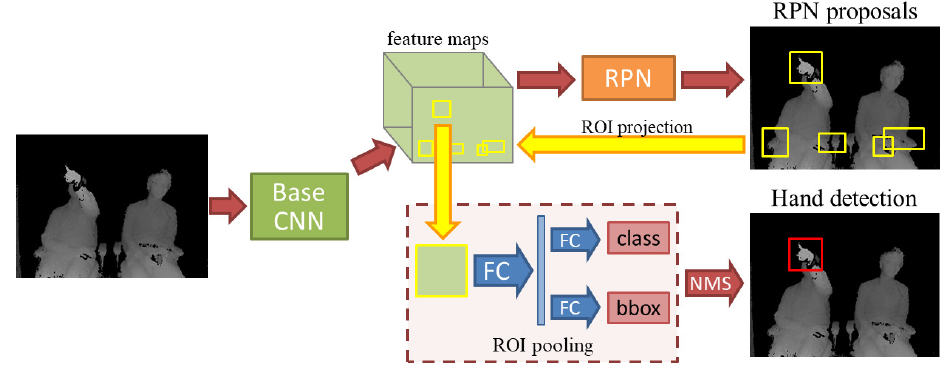
Figure 3. Hand detection process based on faster RCNN [30]. The raw frame is processed by the base CNN, which in our case comprises the first convolutional layers of ResNet-101 [40]. The region proposal network (RPN) generates regions of interest (ROI) from the feature maps obtained by the base CNN. Subsequently, ROIs are pooled and mapped to feature vectors by fully connected layers (FC), which are used for classification and regression of bounding boxes. Finally, the hand region is defined by the non-maximum suppression (NMS) algorithm.